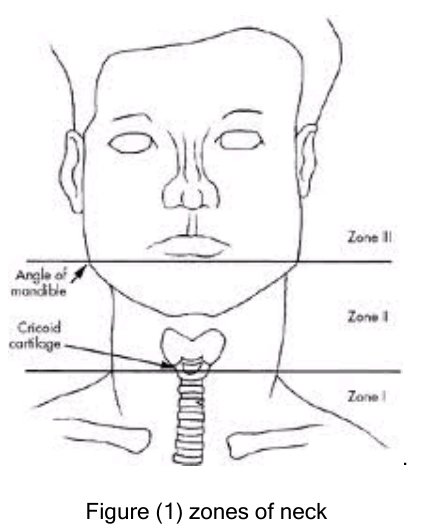
Figure (1) zones of neck